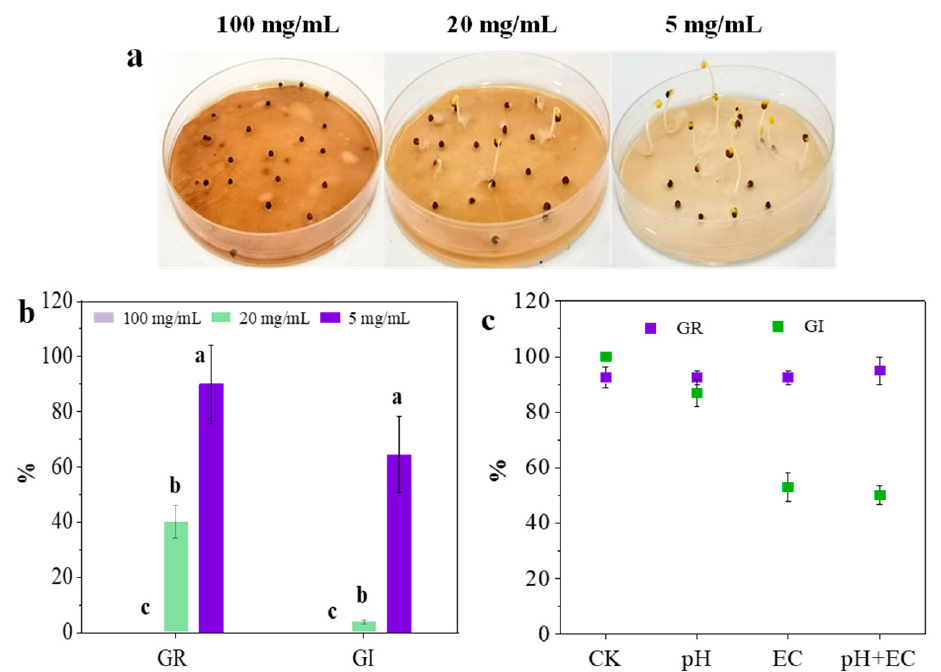
Figure 1. Seed germination of C. camphora extract ( a , b ) and deionized water samples ( c ). Deionized water samples are characterized by the same pH (5.5) and EC (0.8 mS/cm) value in 100 mg/mL of C. camphora extract. (The significant differences among different treatments are marked with different letters, p < 0.05).